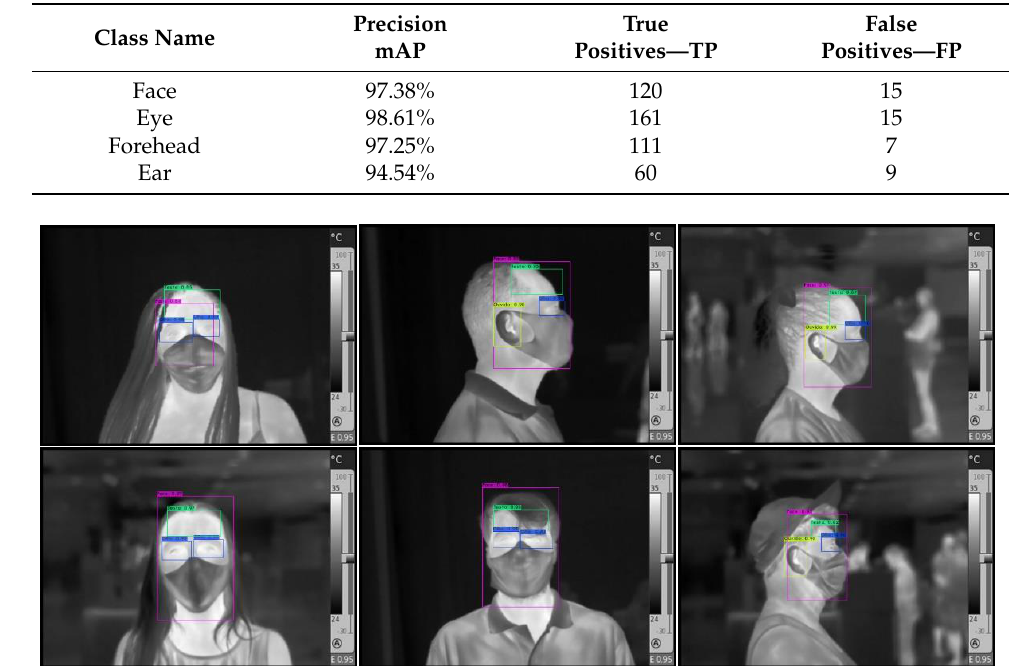
tracted. Thus, the algorithm discards regions covered by hair, sweat, and fabric, which are